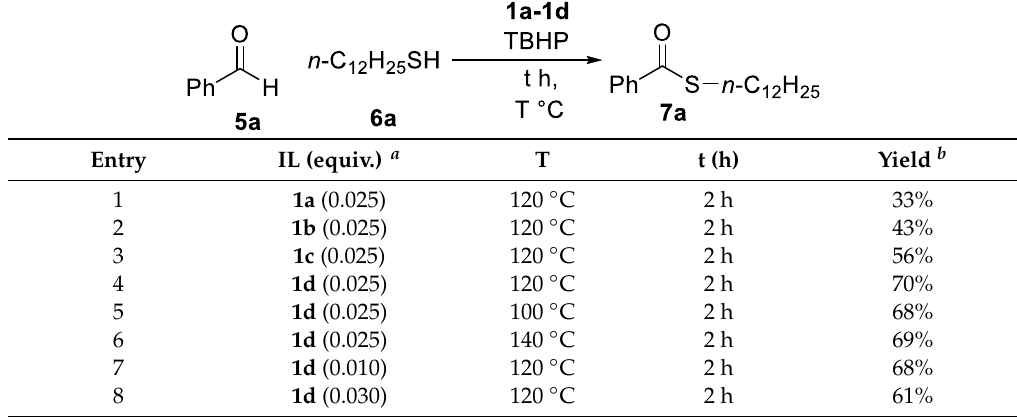
Table 3. Optimized condition of thioesterification.